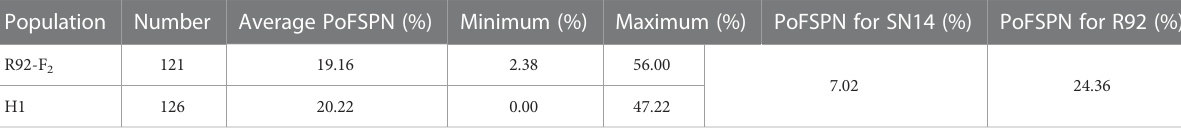
Table 4; Supplementary Table 5; Supplementary Table 6). The